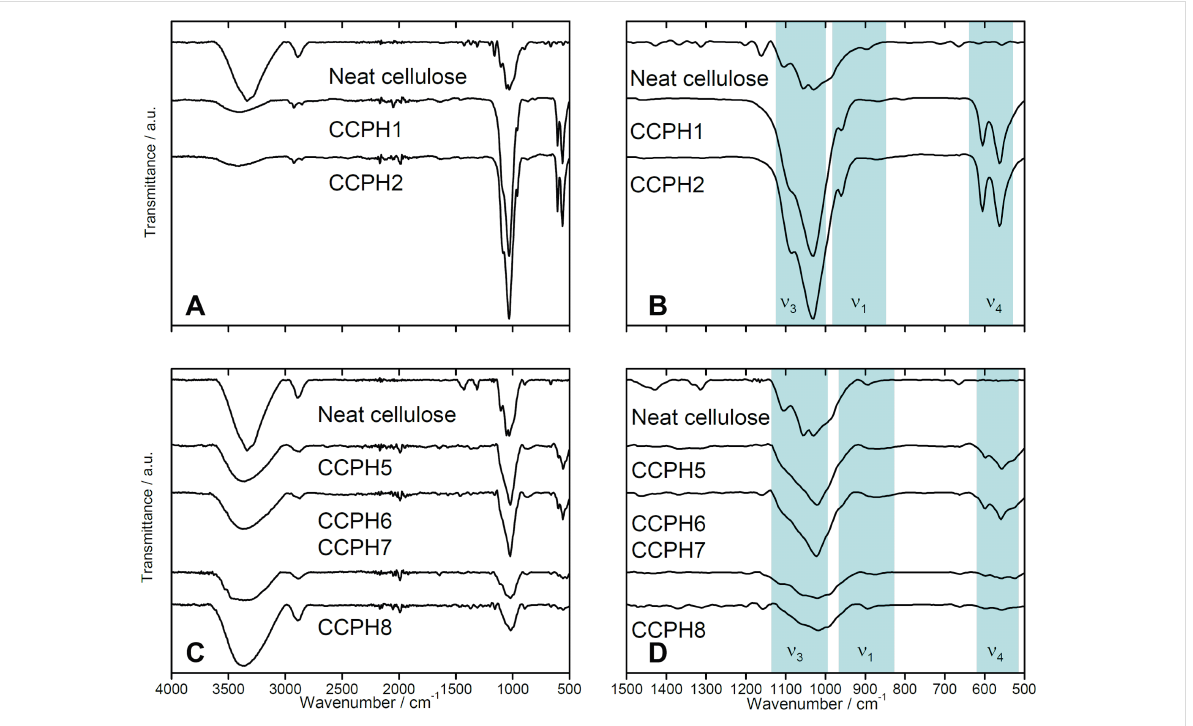
Figure 9: ATR-FTIR spectra of neat cellulose, for sample nomenclature see Table 3. Panels B and D are higher magnification views of the region showing the calcium phosphate vibration bands. Spectra are shifted vertically for better visibility.